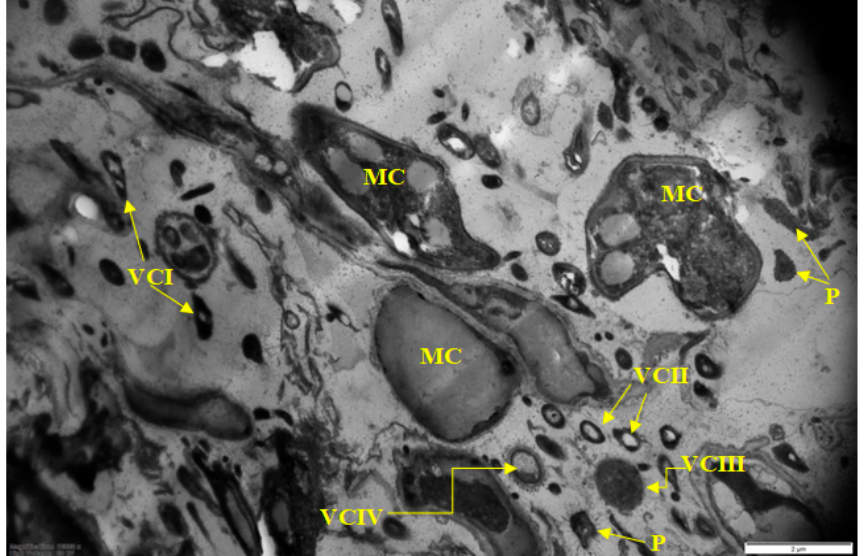
Figure 1. Electron micrograph of sample 1 biofilms. Designations: VC I; VC II; VC III, VC IV—vegetative cells of I–IV morphotypes, respectively; P—persisters covered with a fibrillar layer; FL—fibrillar layer; MC—meat cells. Scale bar is 2 µm.